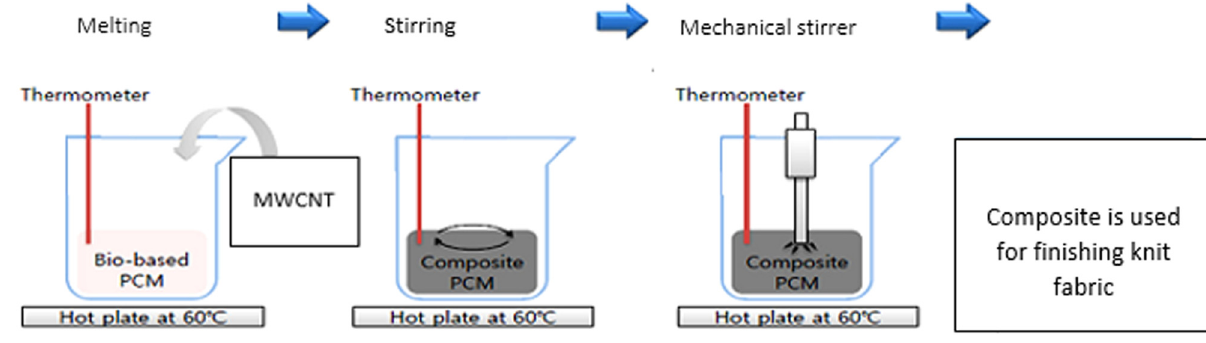
Figure 1: Preparation of CA/MWCNT composite.